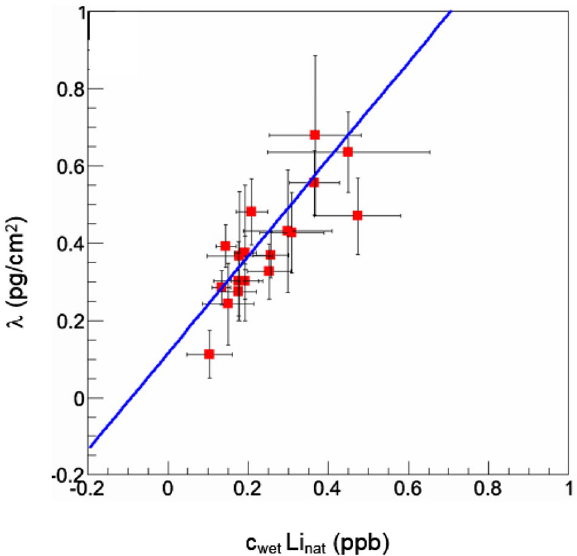
Figure 1. Case I: Correlation diagram c wet Li nat and λ. The offset of the correlation fit indicates the level of the systematic uncertainty for the transformation from an areal density λ to a concentration in the native tissue.